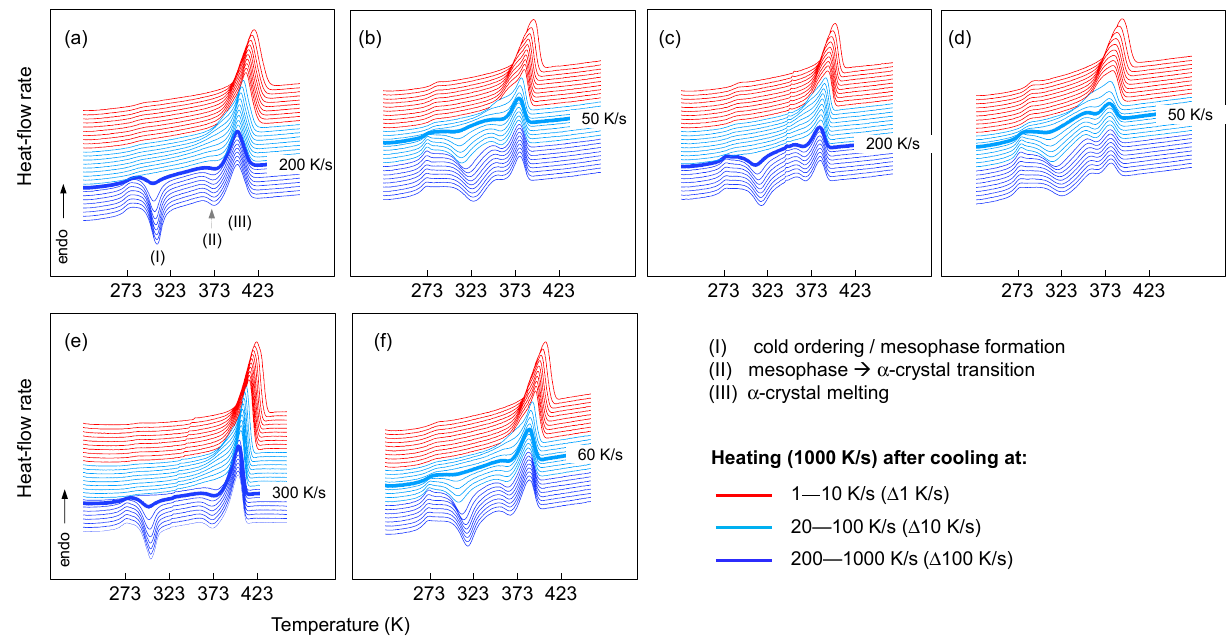
Figure 4. Heat-flow rate data of iPP, iPP.Eth and iPP.Hex copolymers based on SSC ( top ) and ZN ( bottom ) catalysts as a function of temperature, measured upon heating samples at 1000 K/s that were previously cooled at different rates. Bold curves indicate prior cooling at rates as indicated at the right-hand side of each curve. ( a ) SSC.iPP-0; ( b ) SSC.iPP.Eth-3; ( c ) SSC.iPP.Hex-3; ( d ) SSC.iPP.Hex-5; ( e ) ZN.iPP-0; ( f ) ZN.iPP.Eth-4.